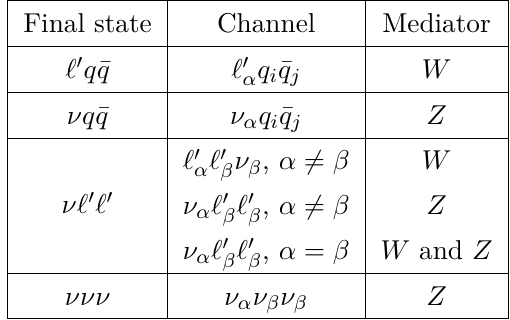
‘ 0 ‘ 0 process with α = β α β β